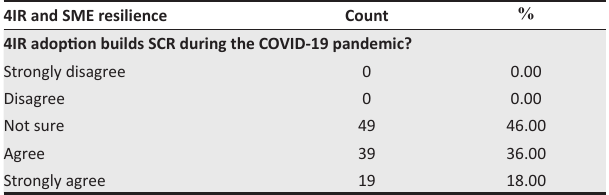
TABLE 2c: Small and medium enterprise supply chain and Fourth Industrial Revolution technology